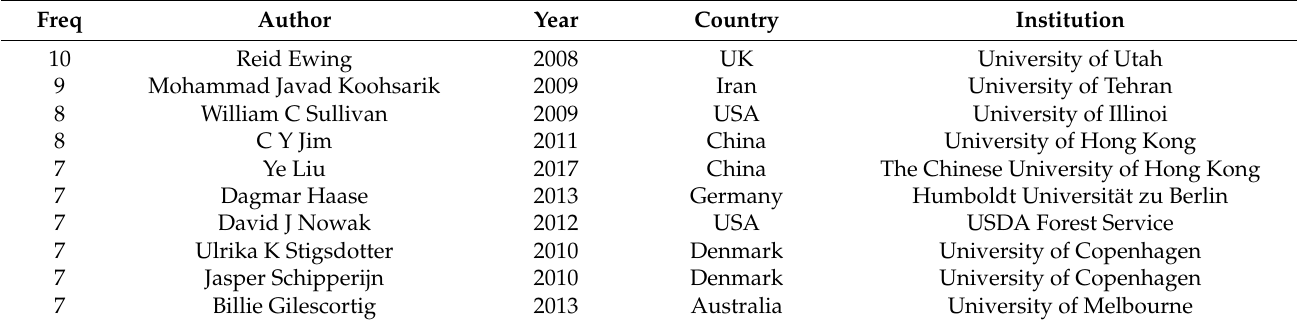
Table 5. Top 10 most productive authors in healthy urban planning research: 1981–2020.